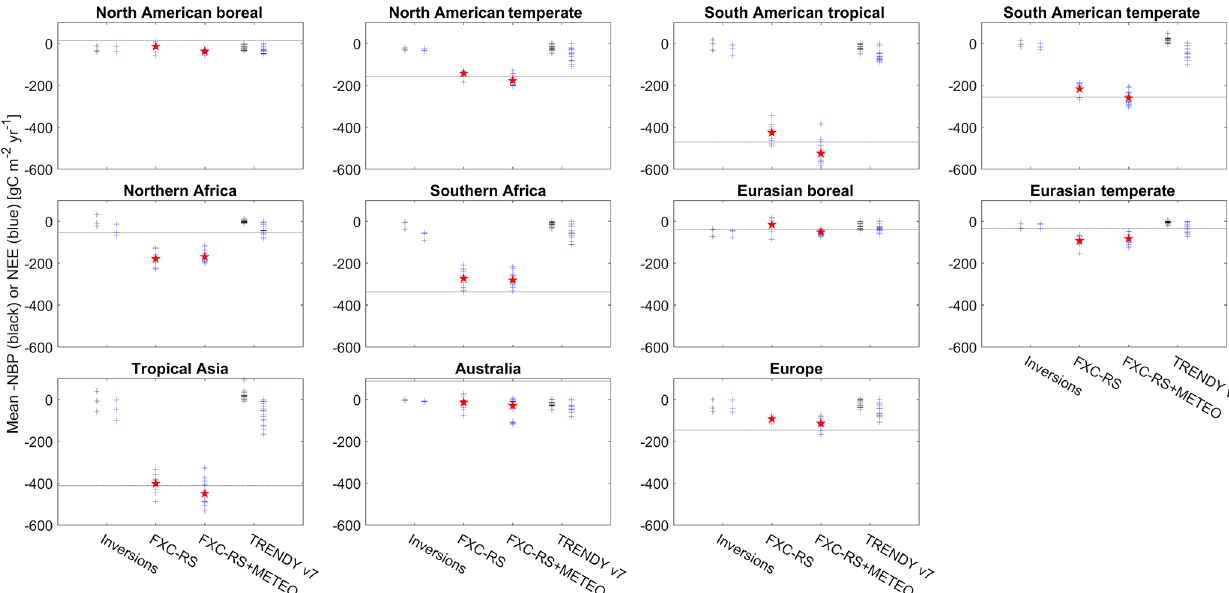
Figure 6. Mean annual net carbon release for the years 2008–2010 over TRANSCOM regions. Crosses refer to individual ensemble members where black refers to negative net biome productivity (NBP, not available for FLUXCOM), and blue refers to net ecosystem exchange (NEE). For inversions, NEE was approximated by correcting NBP with fire emissions (see Sect. 2.4.3). The filled red stars refer to estimates by the ensemble product of FLUXCOM setups. The horizontal line indicates the estimate of